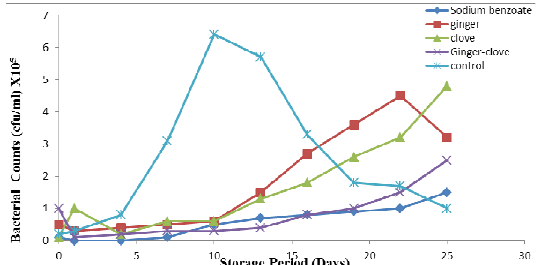
Fig. 2. Effects of different treatments on bacterial counts of soymilk samples at 3% concentration stored at refrigerated temperature for 25 days